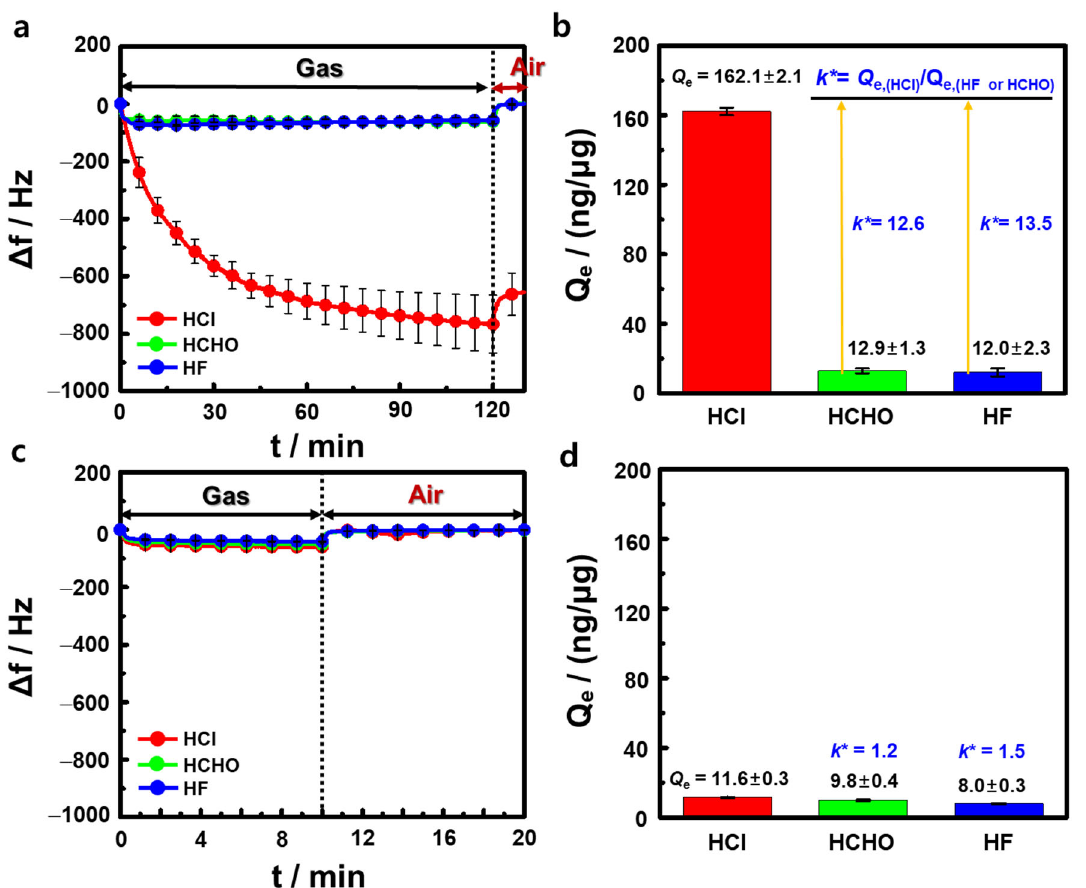
Figure 6. ( a ) Resonant frequency change ( Δ f ) for poly(DMAEMA ‐ co ‐ EGDMA) film as a function of time in flow of 70 ‐ ppm different gases (HCl, HCHO, and HF), at 22 °C and 10% RH, during a 2 ‐ h adsorption process and ( b ) 2D bar plot of equilibrium binding capacity ( Q e ) as a function of toxic gas types in flow of 70 ‐ ppm different gases (HCl, HCHO, and HF). ( c , d ) Resonant frequency change